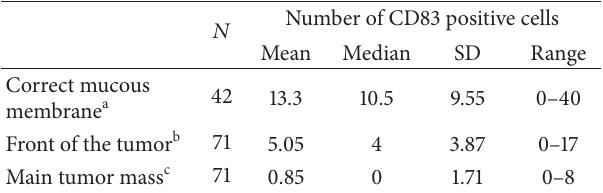
Table 1: The number of CD83 positive cells in normal tumor tissue, in the front of the tumor, and in the main mass of the tumor in colorectal